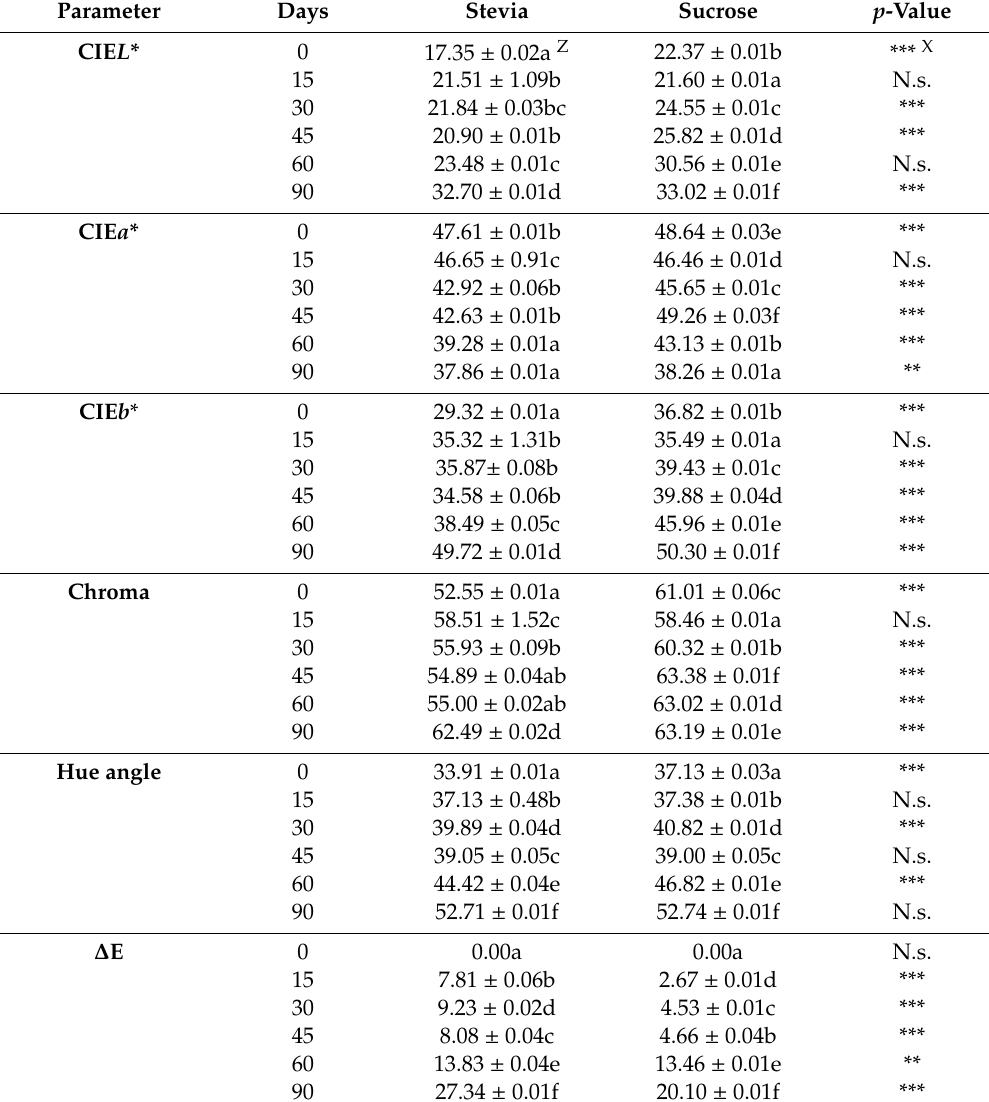
Table 4. CIE L * a * b * values in beverages stored at 25 ◦ C under light condition.